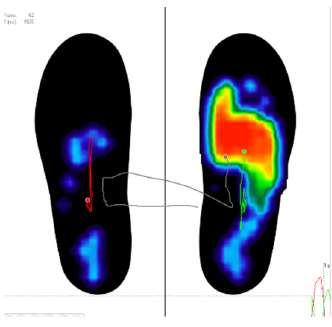
Figure 4. Visual Biofeedback.